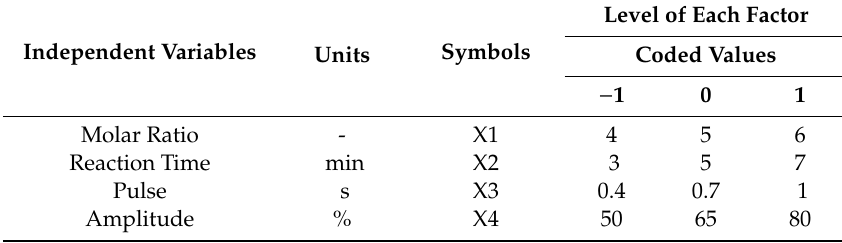
Table 2. Selected independent variables in the response surface method.